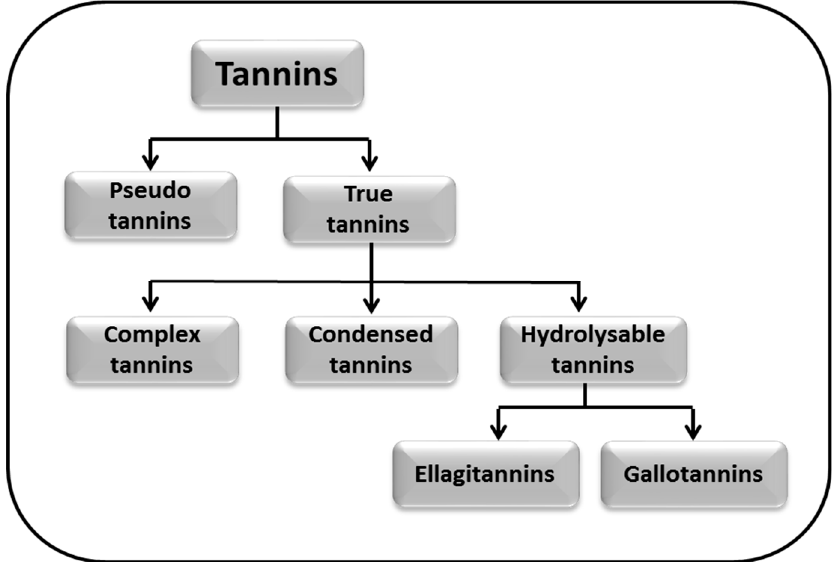
Figure 2. Classification of tannins.